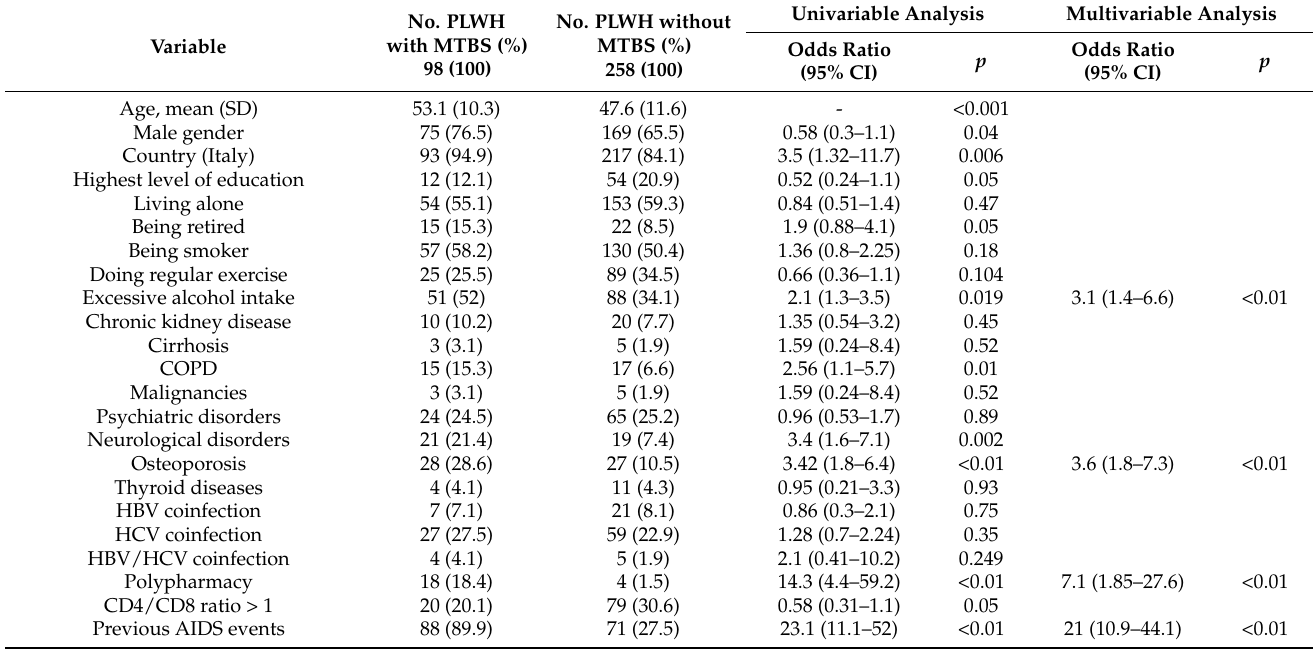
Table 2. Univariate and multivariate analyses of risk factors associated with metabolic syndrome in